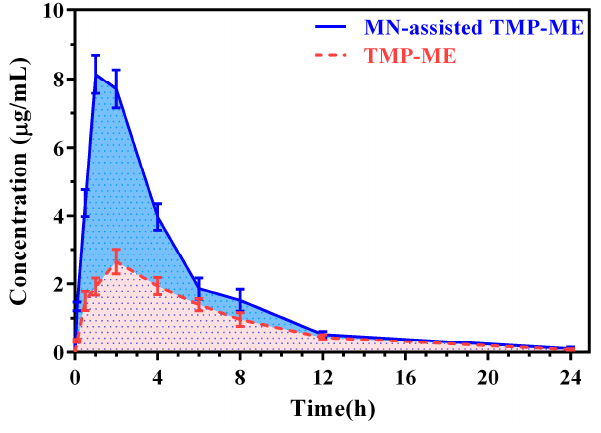
Figure 5. TMP levels in rat plasma for TMP-ME and MN-assisted TMP-ME ( n = 5). Table 3. TMP pharmacokinetic parameters for TMP-ME and MN-assisted TMP-ME in the pharmacokinetic study.